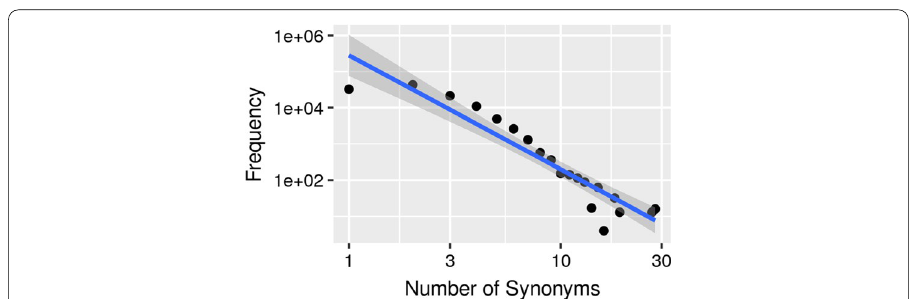
Fig. 13 Synonym hyperedge cardinality distribution (log–log